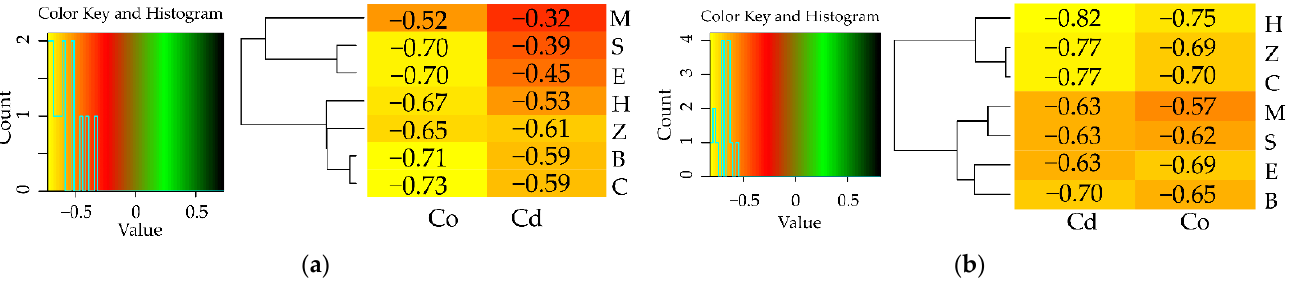
Figure 7. Index of the influence of heavy metals (IF Hm ) on the yield of ( a ) aboveground parts, ( b ) roots of plants.